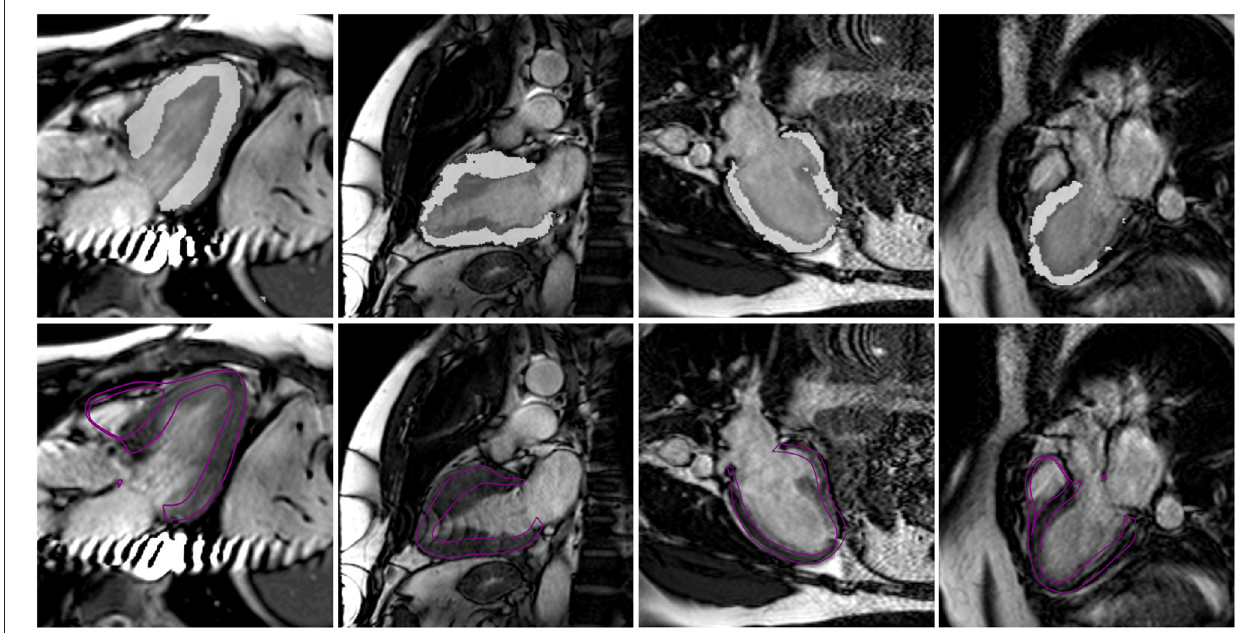
FIGURE 10 | Selected long-axis images which were part of the 12 cases (h1, h4, d2, d4) used in this study which demonstrate poor image quality due to imaging artefacts. In the first row, the LV blood pool and myocardial segmentations obtained using the neural network are overlain on top of each image to qualitatively show the impact of the image quality on the network segmentation. In the second row, the final fitted model surface is shown on top of the image.